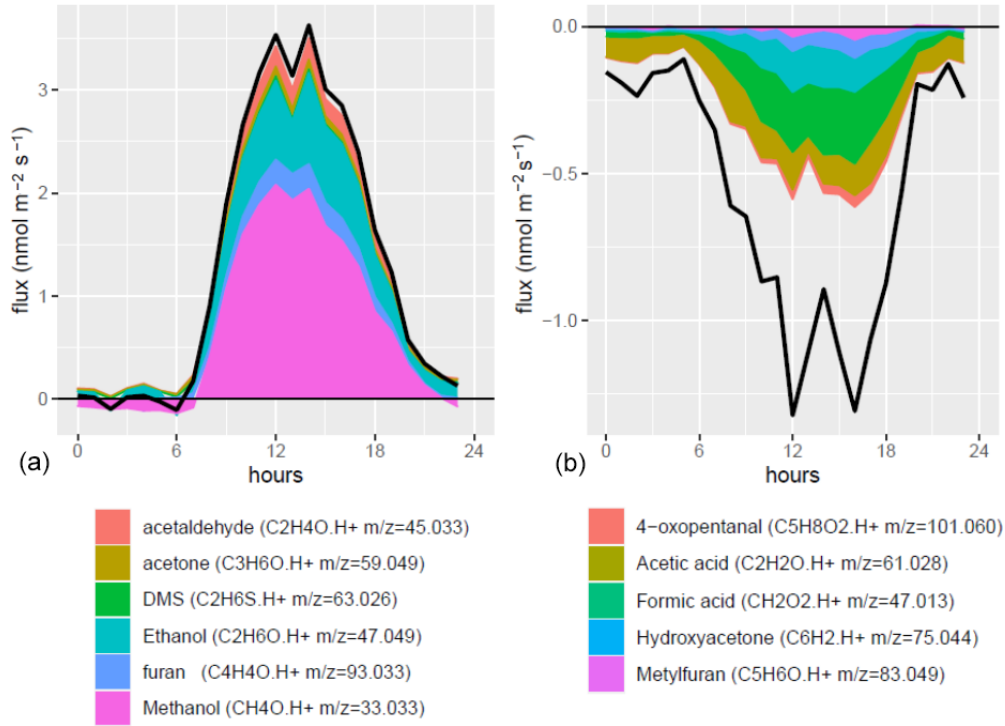
Figure 7. Stacked daily averages of the six most emitted (a) and six most deposited (b) VOCs. Black lines show summed-up emissions and depositions for compounds with fluxes larger than LOD f